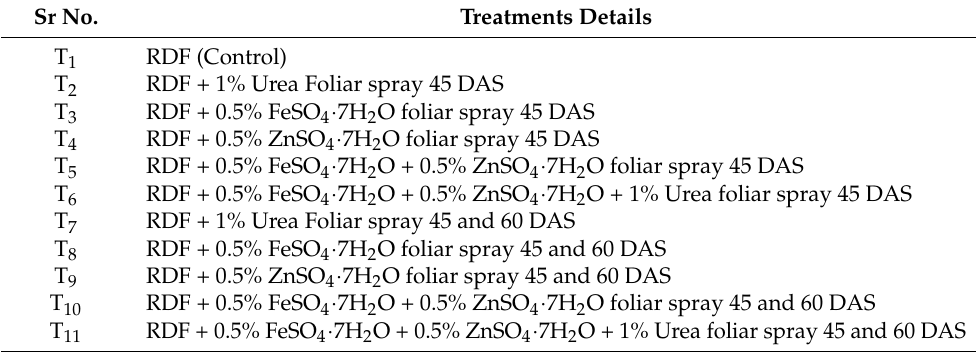
Table 1. Treatment details of urea and micronutrients foliar spray on Indian mustard. Sr